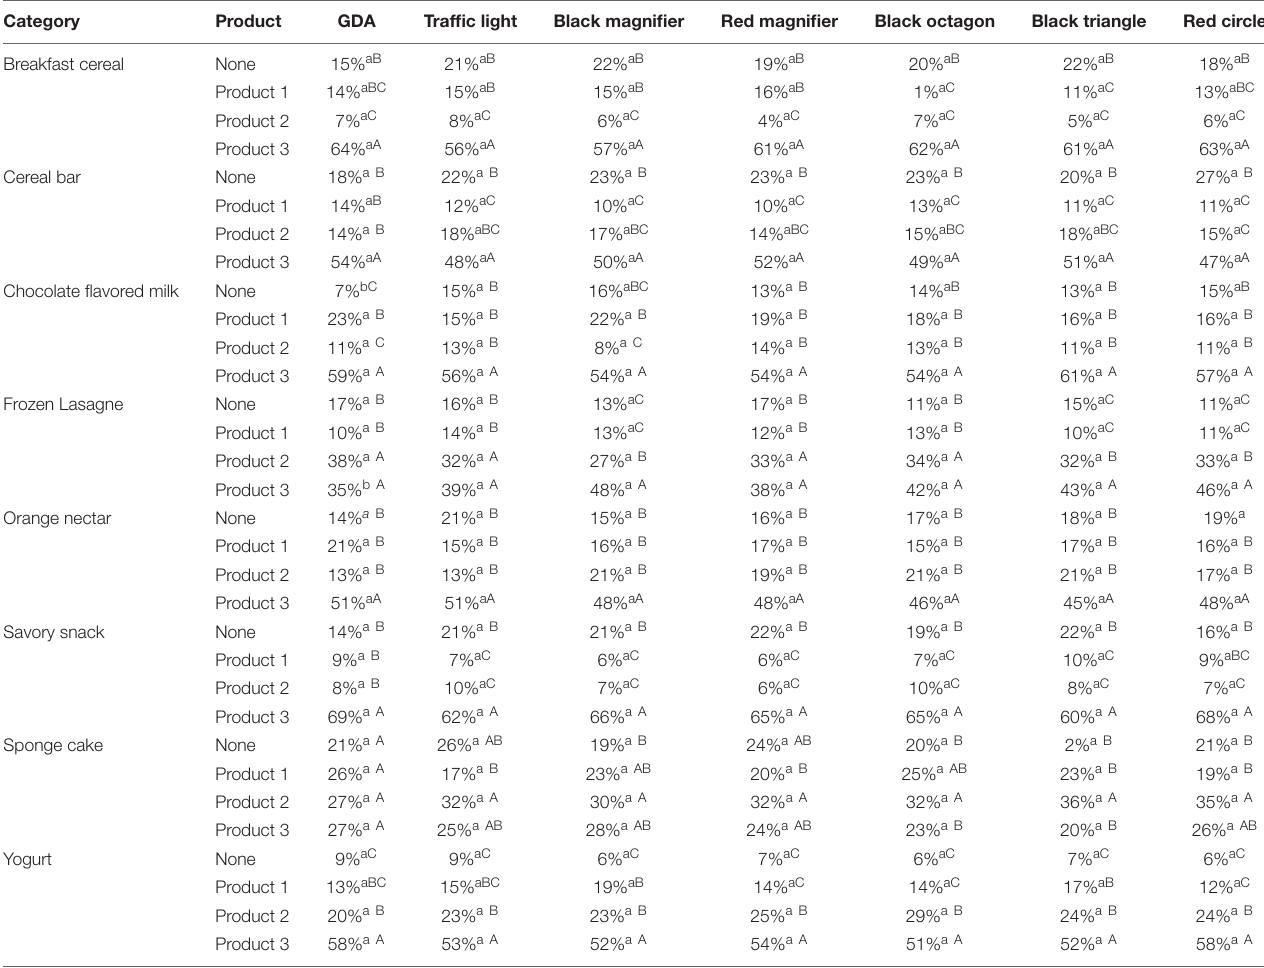
TABLE 3 | Percentage of participants who selected each of the product in the choice task. Category Product GDA Traffic light Black magnifier Red magnifier Black octagon Black triangle Red circle Breakfast cereal